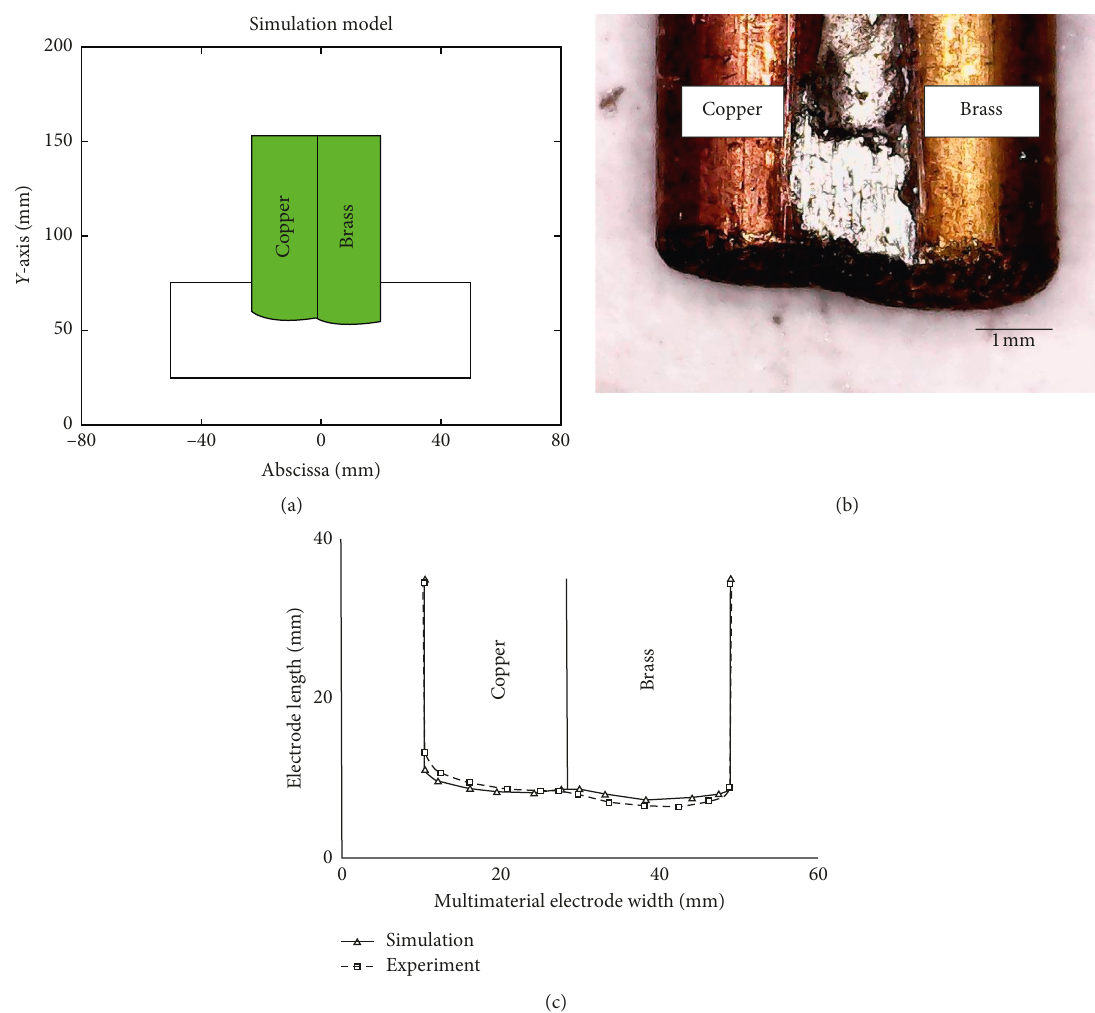
Figure 9: Comparison of simulation and experimental results of multimaterial electrodes for two materials. (a) Copper-brass simulation results. (b) Copper-brass experimental results. (c) Simulated extraction curve and experimental identification